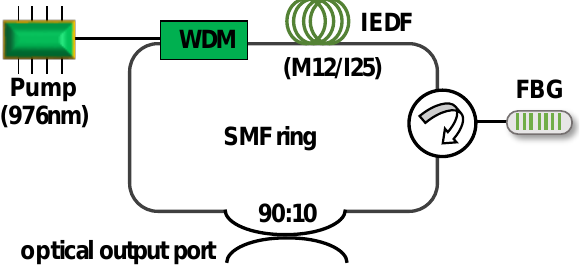
Figure 1. Schematic of the fiber ring cavity configuration, where several irradiated erbium-doped fibers (IEDFs) were used as an active medium.